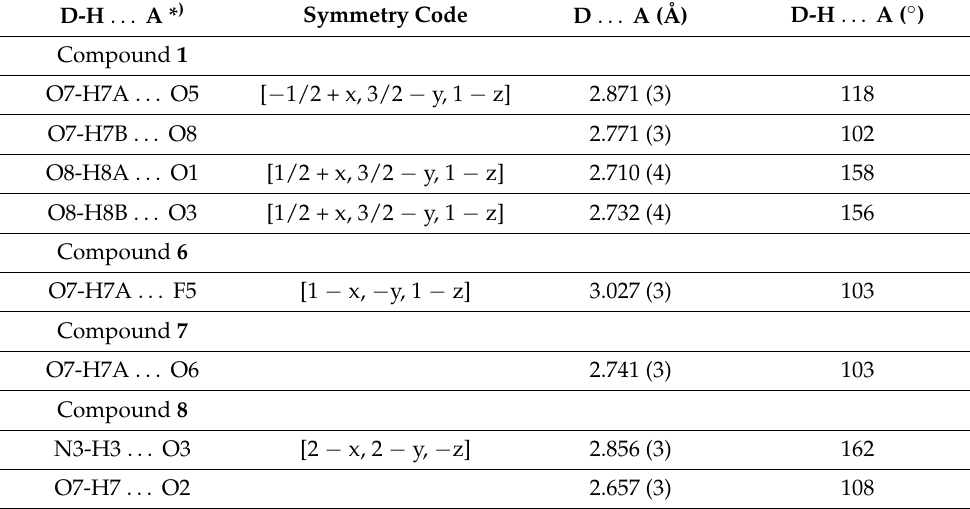
Table 1. Possible hydrogen bonds in 1 , 6–8 .